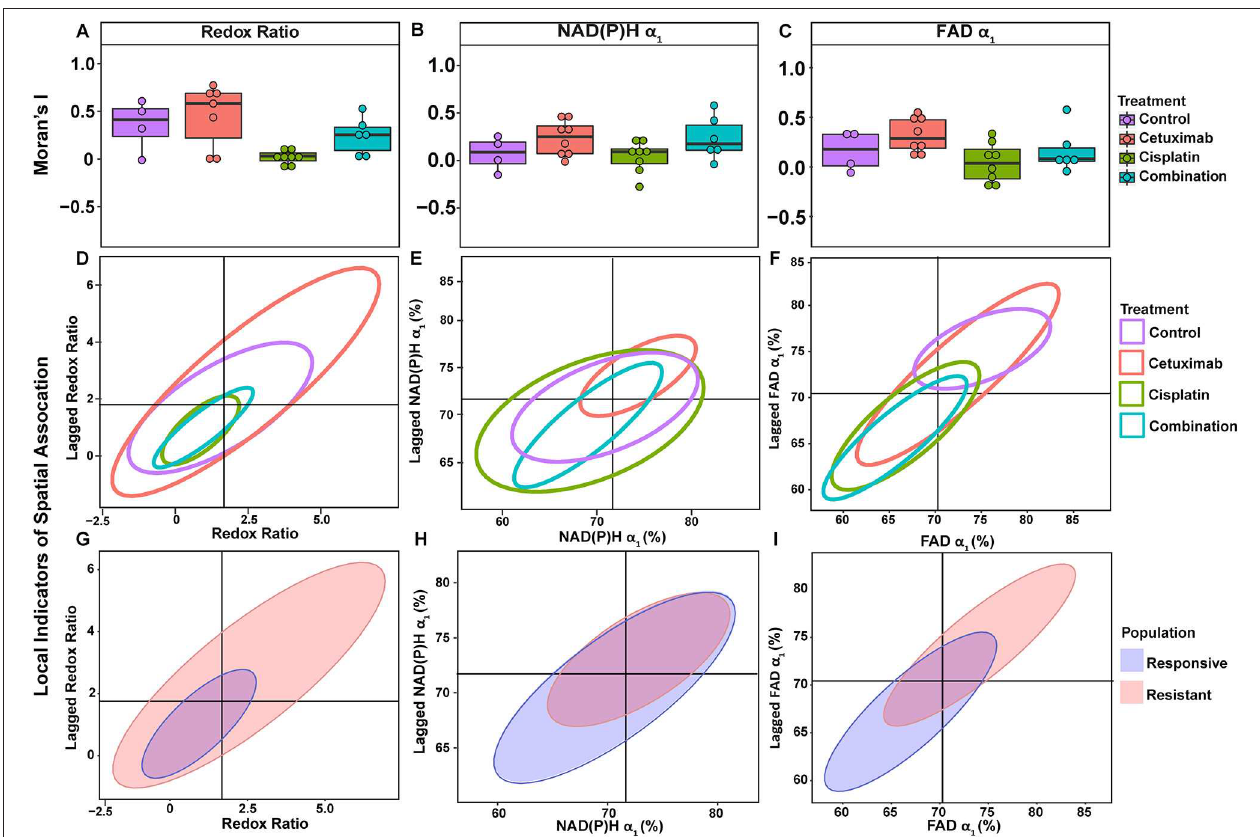
FIGURE 5 | Spatial clustering patterns of metabolic parameters in FaDu organoids. Moran’s I based on (A) redox ratio, (B) NAD(P)H α 1 , and (C) FAD α 1 measurements for control and treated organoids. (D–F) Ellipses represent the distribution of cell clusters, with cells falling in the upper right (homogeneously high value clusters) and lower left quadrants (homogeneously low value clusters). Clustering is plotted for each treatment group for (D) redox ratio, (E) NAD(P)H α 1 , and (F) FAD α 1 . Cluster patterns of responsive and resistant cells are plotted for (G) redox ratio, (H) NAD(P)H α 1 , and (I) FAD α 1